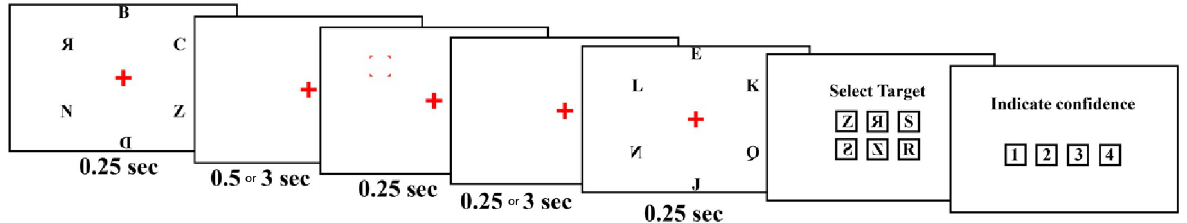
Fig 3. An overview of the procedure of Experiment 2. Each trial started with a fixation cross for 0.5 seconds (not depicted), followed by the depicted sequence of events. The final two response displays remained visible until the participant had indicated her choice.